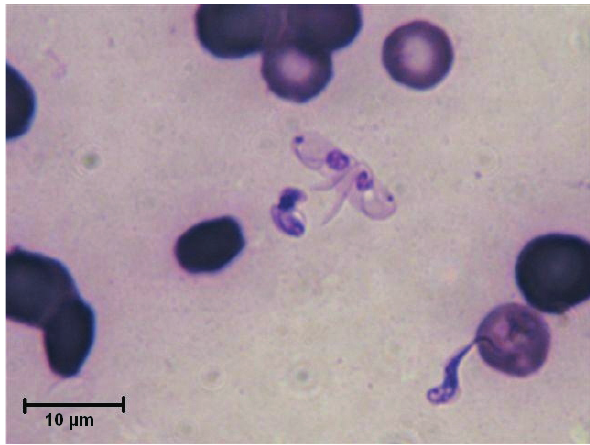
Fig. 12. – Twin T. (Nannomonas) hyperpachymorph and one iso- morph. Photo by Sophie